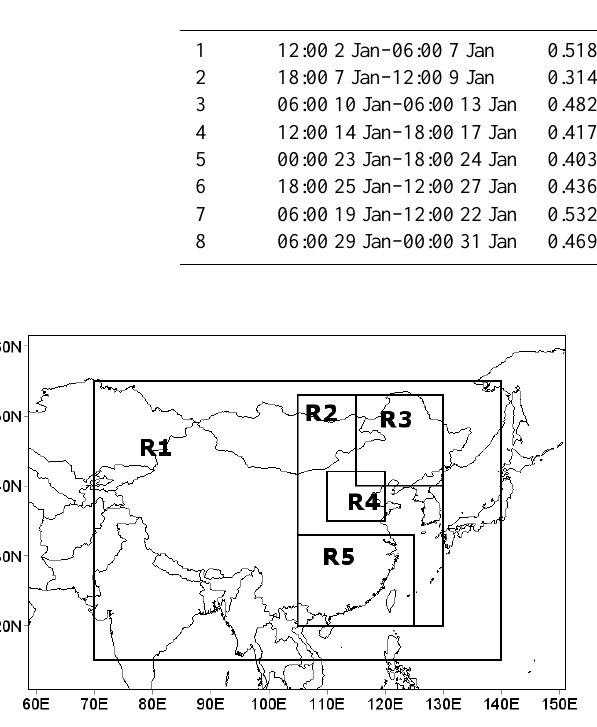
Table 1. Threat score comparisons for eight precipitation events for T1, T2, and T3. Cases